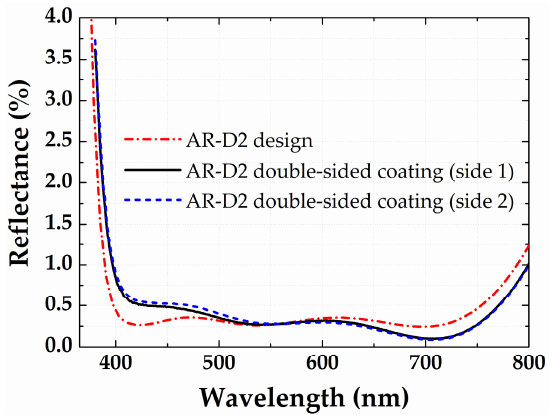
Figure 6. Measured and expected reflectance spectra (AOI = 0 ◦ ) of AR-D2 deposited simultaneously on both sides of an upright-positioned flat fused silica glass substrate.